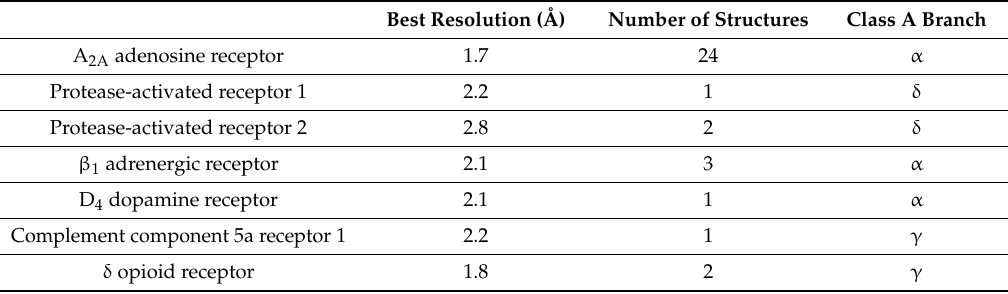
Table 1. Crystallographic structures of class A G protein-coupled receptors (GPCRs) deposited on the Protein Data Bank (PDB) and containing a sodium ion in the transmembrane helices (TM)